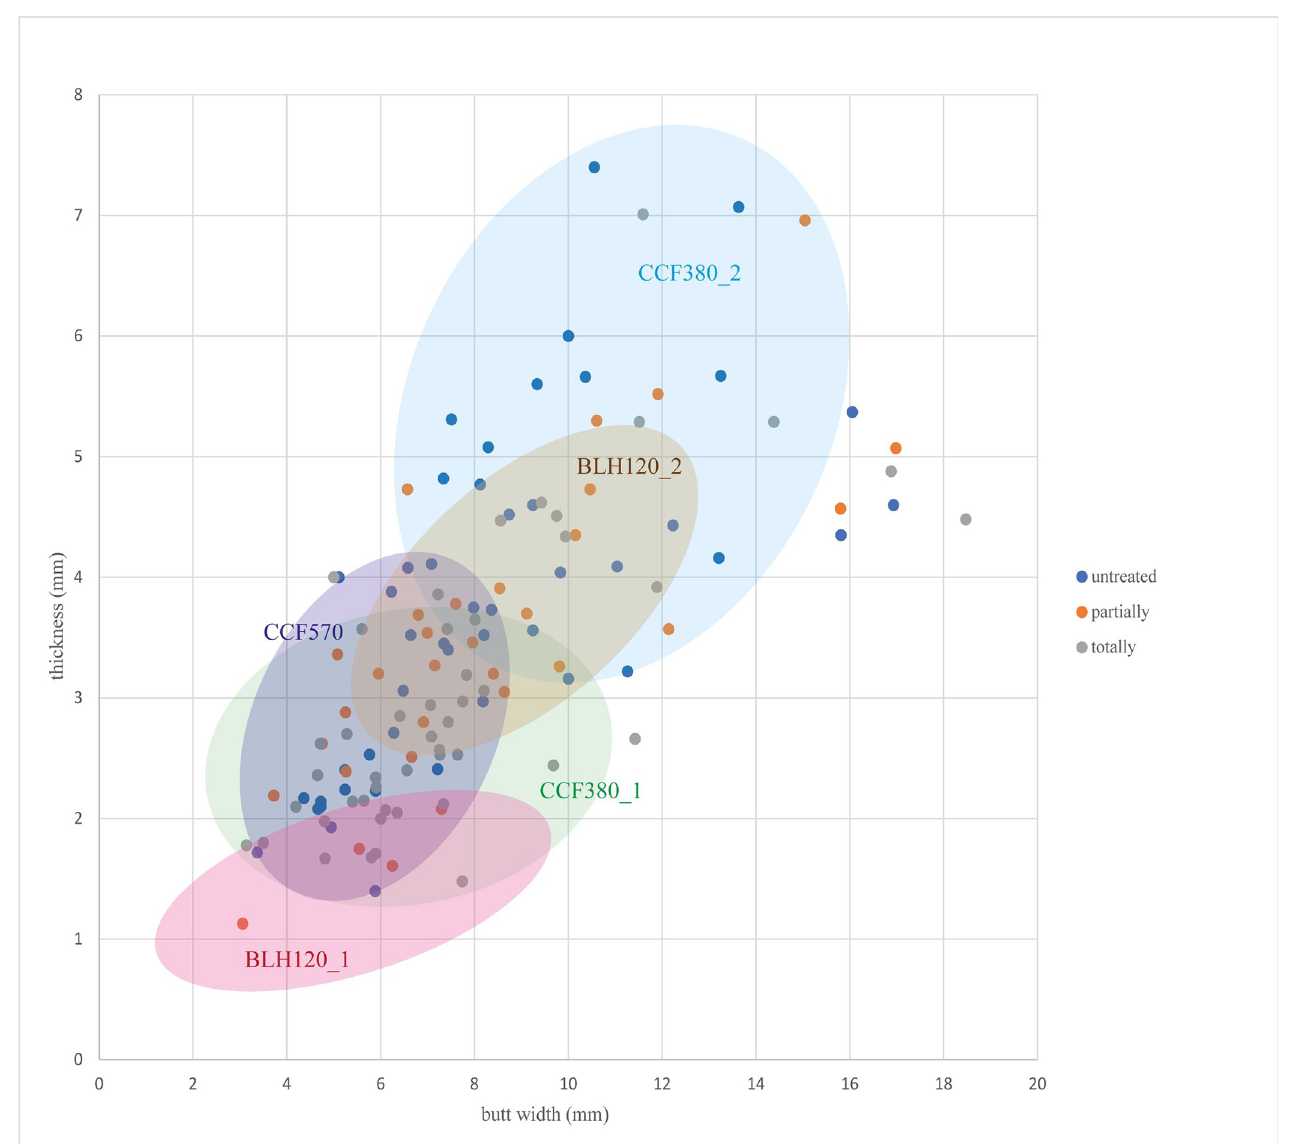
Fig 7. Comparison of ranges of the 5 recognized groups based on butt measurements by overhang preparation